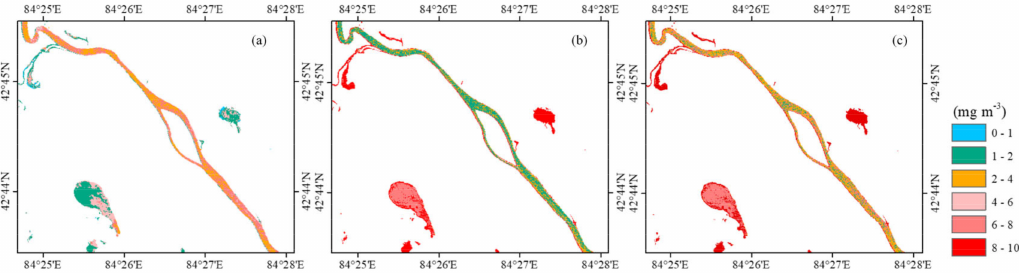
Figure 8. Spatial distribution of estimated chl-a using the OC2V4 ( a ), D3B ( b ), and OC2-D3B ( c ).